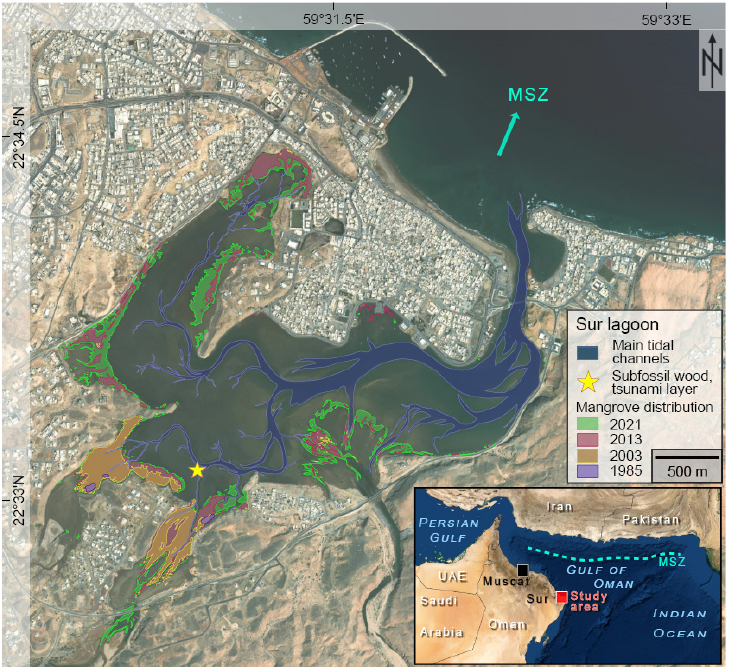
Figure 1. Aerial photo of the Sur lagoon, showing the recent tidal channel system in blue and the modern mangrove distribution in green. The pink, brown, and purple colors indicate mangrove distribution in 2013, 2003, and 1985, respectively. The star marks the trench site, and the turquoise arrow points towards the Makran subduction zone (MSZ) (source: satellite image from Google Maps). Inset: location of the study area in Oman on the northeastern Arabian Peninsula (source: ESRI data, map created using ArcGIS 2015).